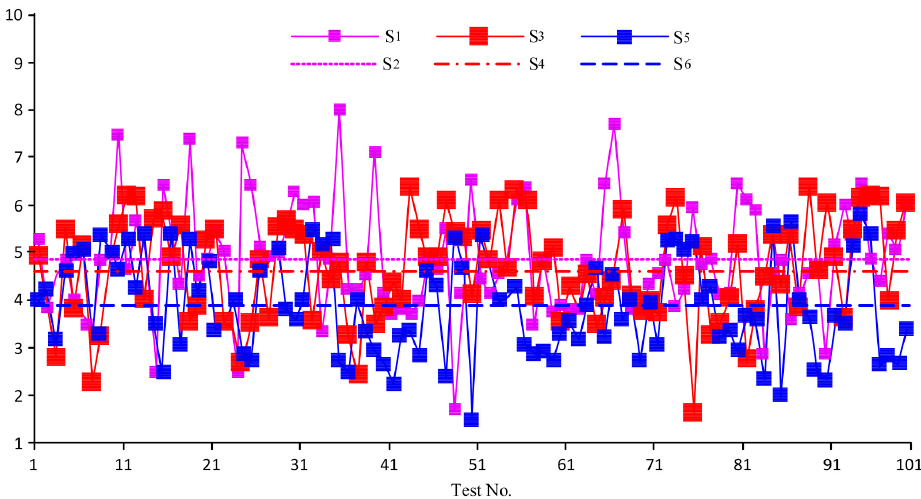
Figure 13. Measurement error curves of the sensor when measuring the bubble flow under different temperatures. S 1 : error at 16 °C and under standard atmospheric pressure; S 2 : mean value of S 1 ; S 3 : error at 58 °C and under standard atmospheric pressure; S 4 : mean value of S 3 ; S 5 : error at 90 °C and under standard atmospheric pressure; S 6 : mean value of S 5 .